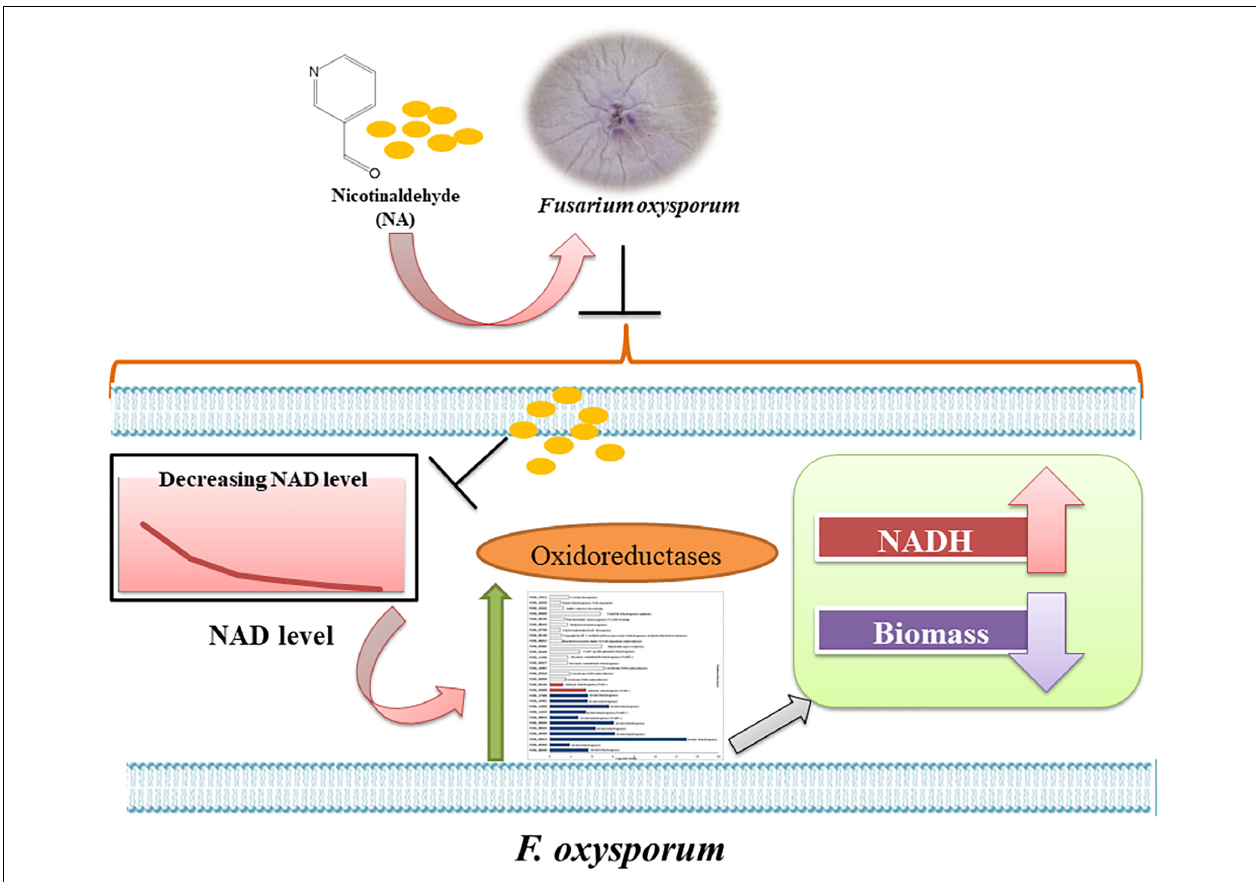
FIGURE 13 | Model of the response of F. oxysporum to NA. Summary of the response of F. oxysporum to NA based on changes in gene expression, NAD status and ROS